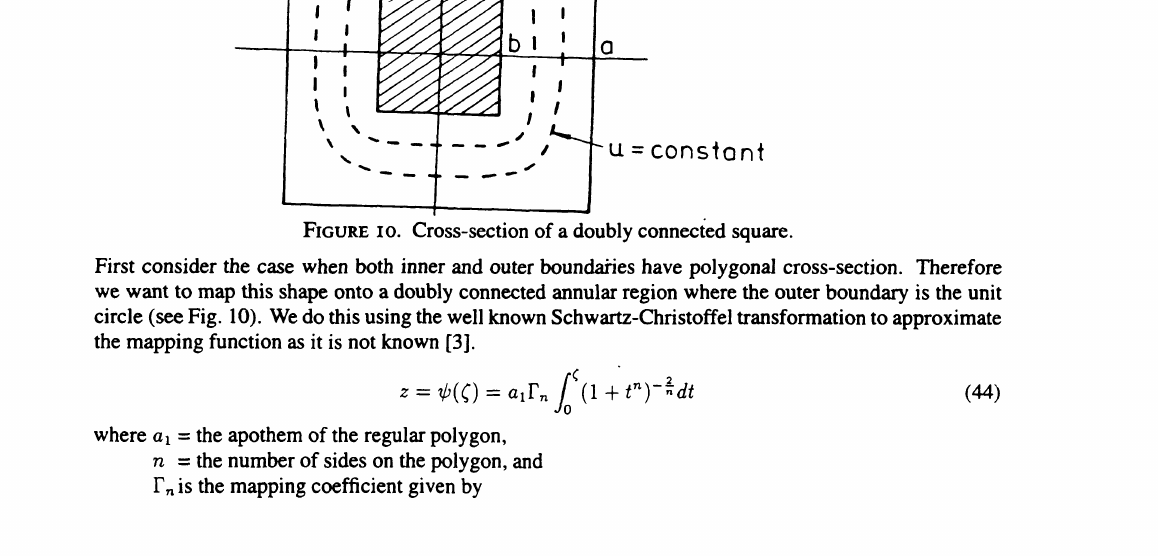
FIGURE 9" Amplitude distribution of the oscillatory flow over the cross-section of a simply connected square with rounded corners for r/= 0, 1,2,3, 4, ( 0.1 and F 0.0,..., 1.0.